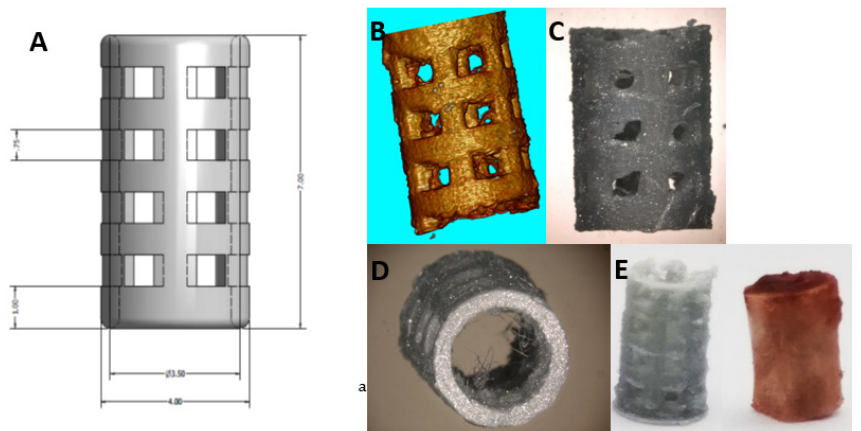
Figure 7. The 3D-printed PLA cylinder. SEM images ( A – D ) and printed PLA cage corresponding to an excised piece of rat femur ( E ).